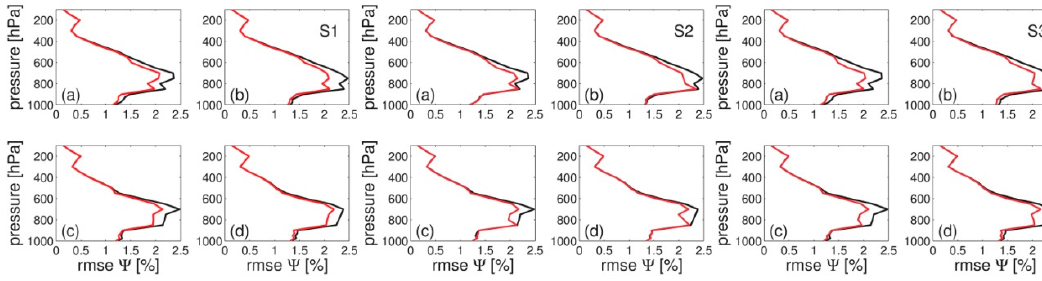
Figure 7. Same as Figure 4 but data from the station network are assimilated.